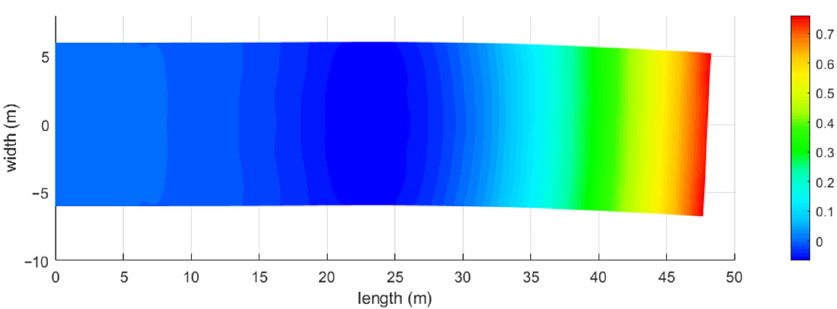
Figure 18. Vertical displacement field of the cantilever beam ( c = 1 Ns/m, t = 0.010 s), under Heaviside step loading with an infinite duration.